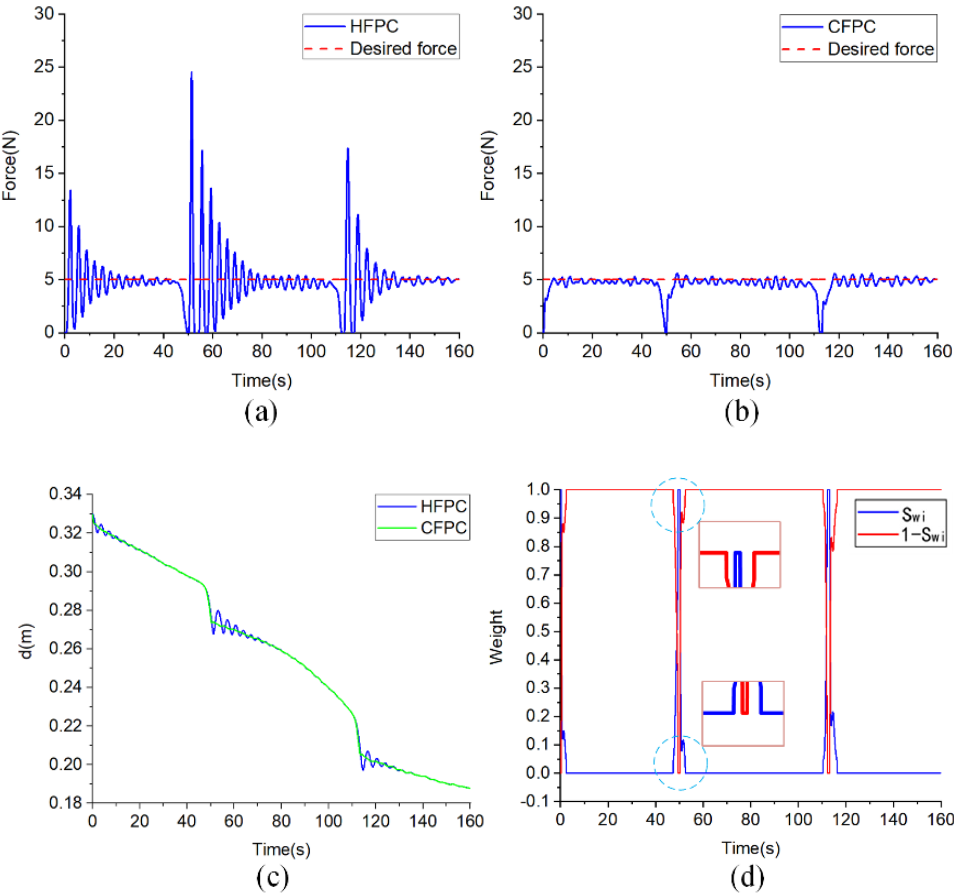
Figure 14. Force-tracking experiment on a complex surface. Force tracking using ( a ) the HFPC and ( b ) proposed CFPC methods. ( c ) Position tracking. ( d ) Weighted parameter